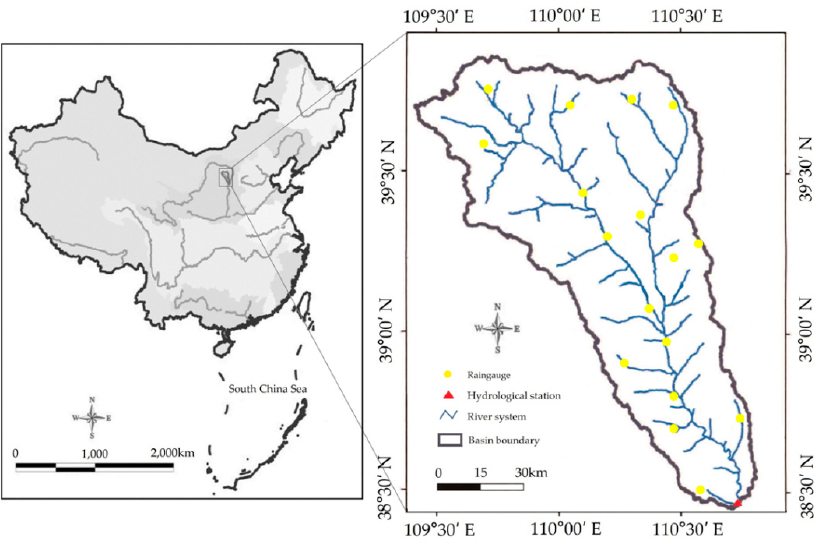
Figure 3. River system and location of the Kuye river basin (KRB), China.